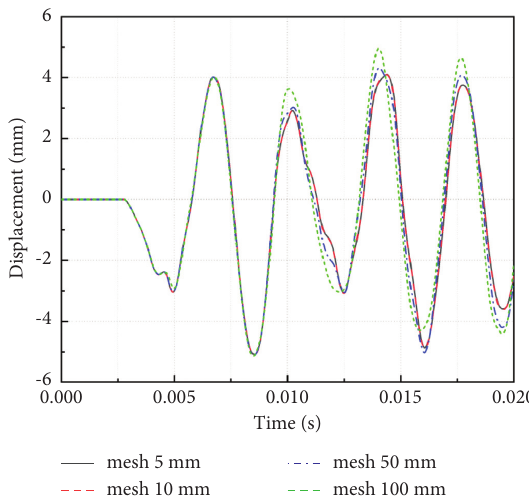
Figure 7: Displacement time history curves of different mesh